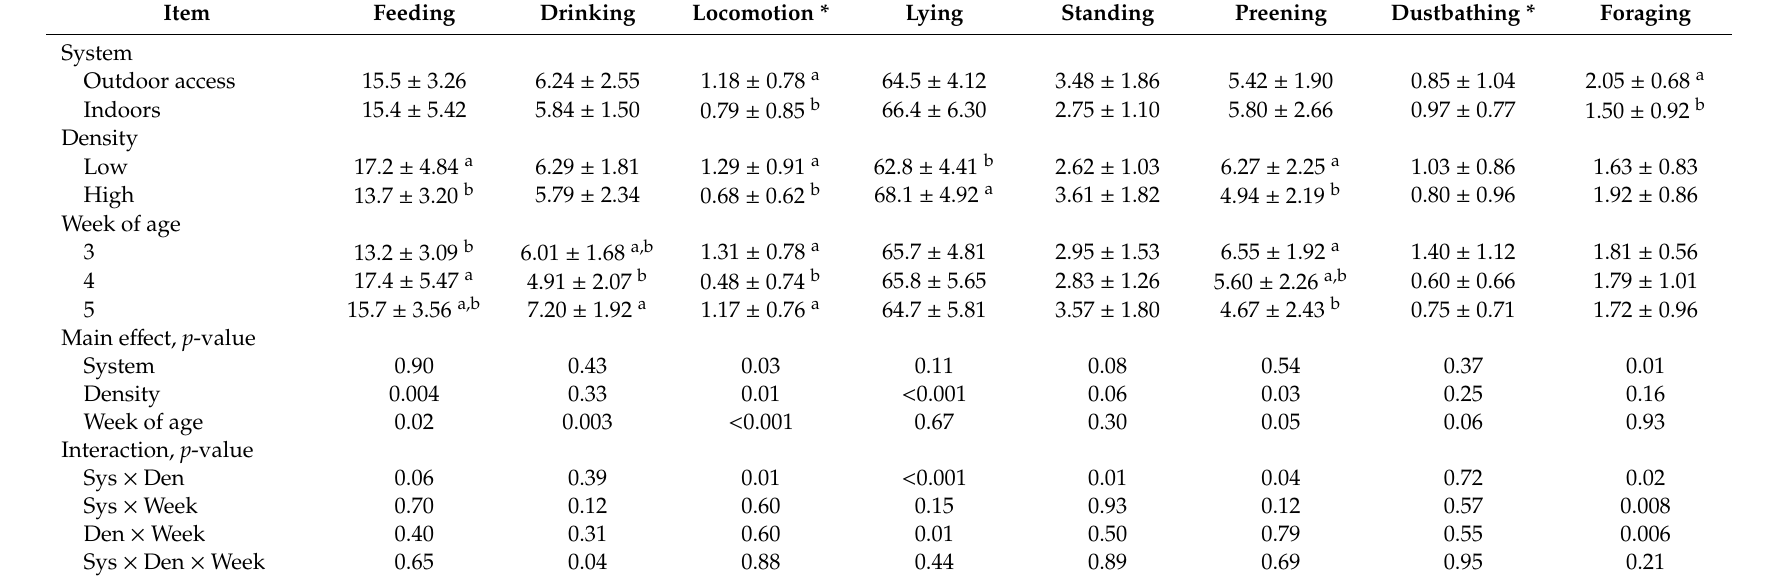
Table 3. Least Square Means of the e ff ects of system, density and week of age on behaviour of commercial-line broilers 1 . Item Feeding Drinking Locomotion * Lying Standing Preening Dustbathing *